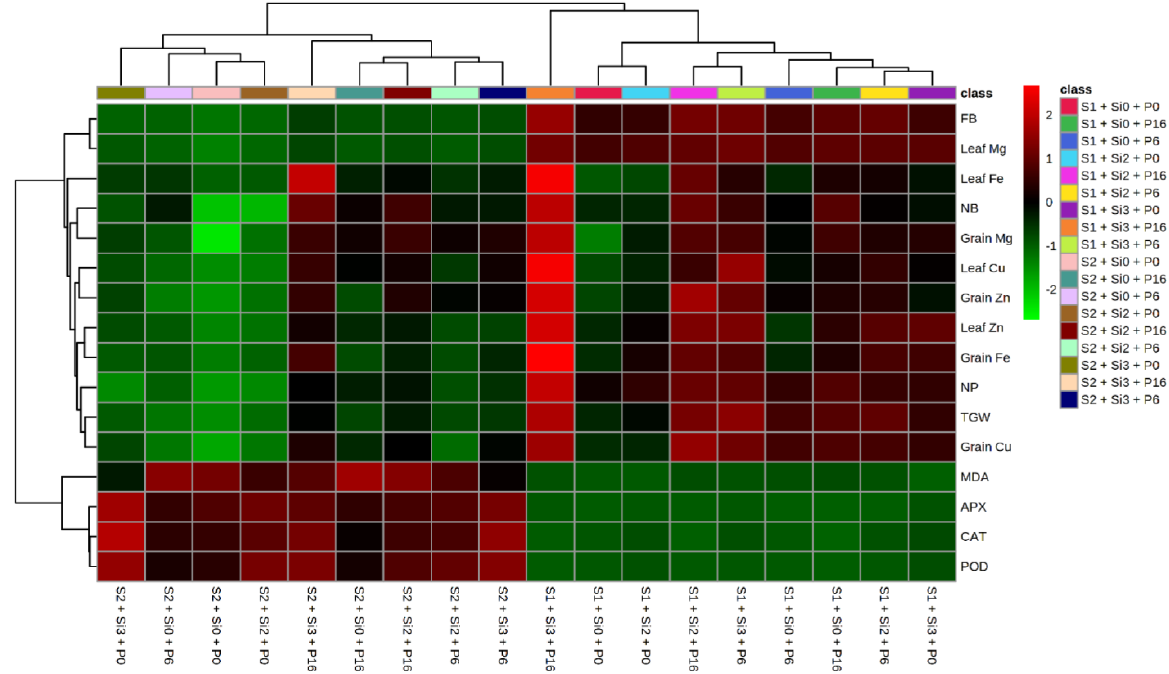
Figure 2. Heat map along hierarchical clustering of all observed variables in response to salinity stress with the applications of silicon (Si) and plant growth promoting bacteria (PGPR) in mung bean crop. Classes on sidebar represent the complete combinations of all set of treatments as P0 = Un-inoculated control, P6 = E. cloacae , P16 = B. drentensis, Si 0 = 0 kg Si ha − 1 , Si 1 = 1 kg Si ha − 1 , Si 2 = 2 kg Si ha − 1 , S1 = Saline irrigation at 3.12 dS m − 1 , S2 = Saline irrigation at 7.81 dS m − 1 . Side bar having gradual intensity of red and green colors shows increase or decrease in the concentration of various attributes, respectively. The complete forms of the abbreviations used for variables are FB, Fresh biomass; NP, Number of pods; NB, Number of branches; TGW, Thousand grain weight; Mg, Magnesium; Fe, Iron; Zn, Zinc; Cu, Copper; MDA, Malondialdehyde; APX, Ascorbate Peroxidase; CAT, Catalase; POD, Peroxidase.